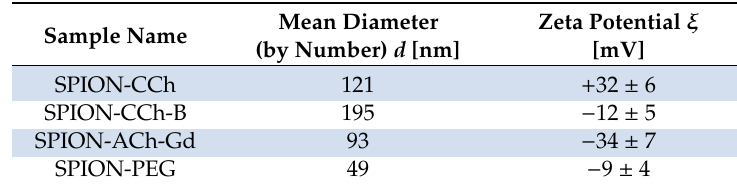
Table 1. The values of the mean hydrodynamic diameter and zeta potential measured by dynamic light scattering (DLS). The uncertainty of zeta potential is also given. SPION: superparamagnetic iron oxide nanoparticles; CCh: cationic derivative of chitosan; ACh: anionic derivative of chitosan; PEG: polyethylene